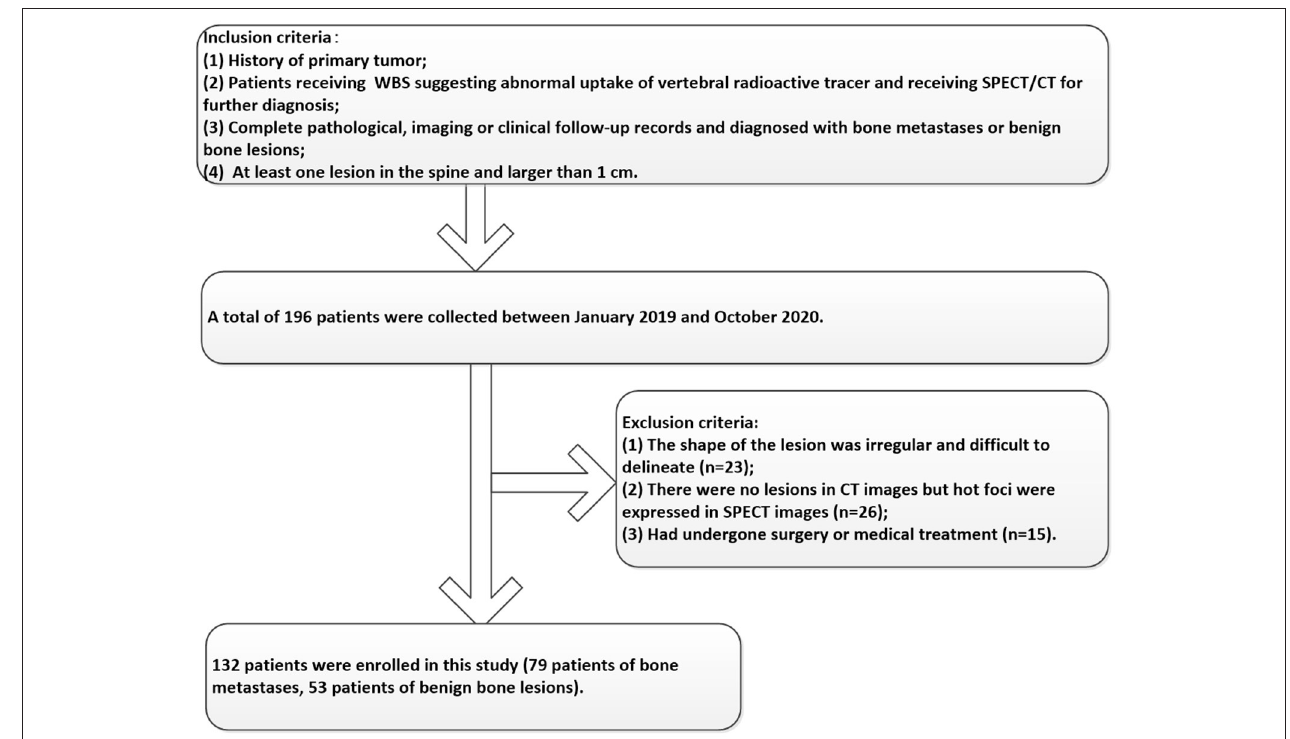
FIGURE 1 | The inclusion and exclusion criteria of our